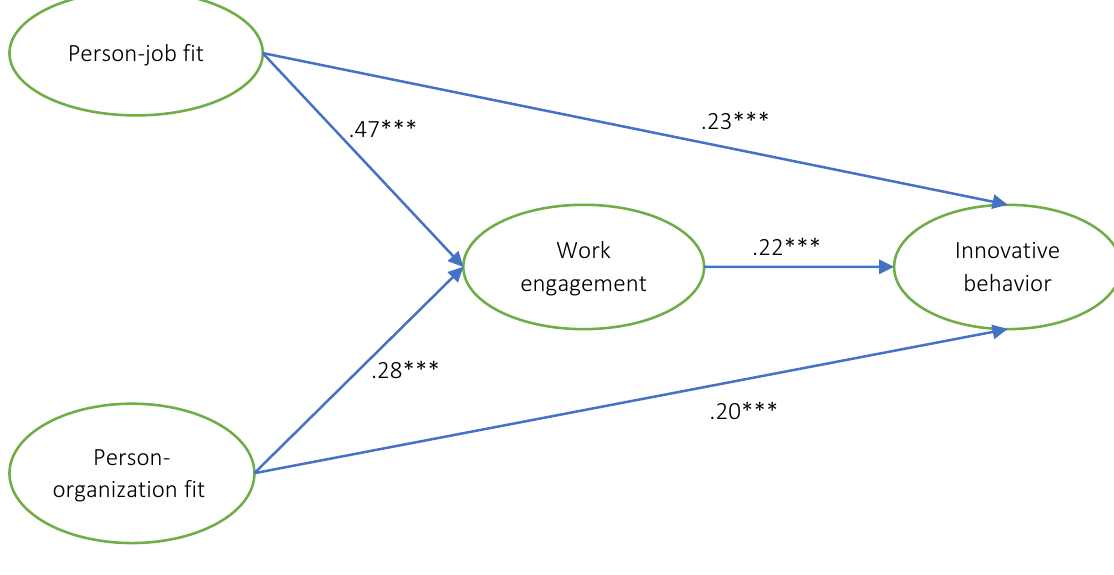
Figure 1. Path model reflecting the coefficient values from structural equation modeling